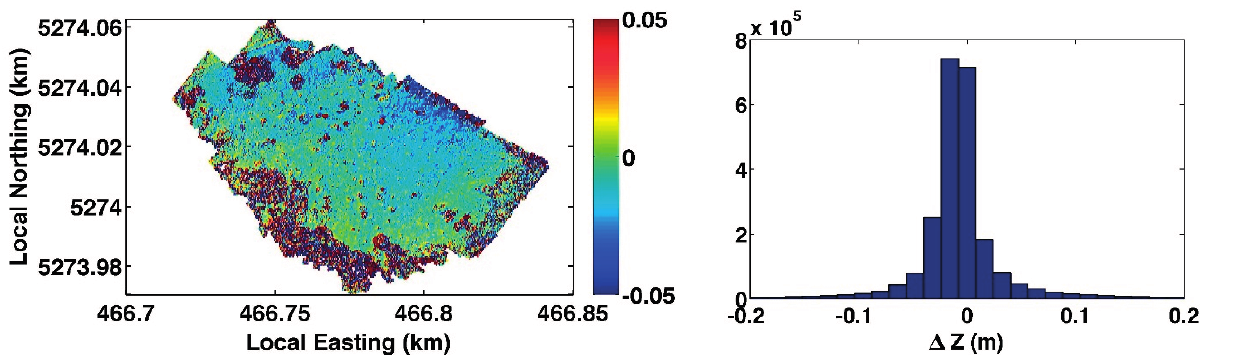
Figure 5. Comparison of our workflow as compared to the current commercial state of the art ( left ) using differenced DEMs. Histogram of the Z differences ( right